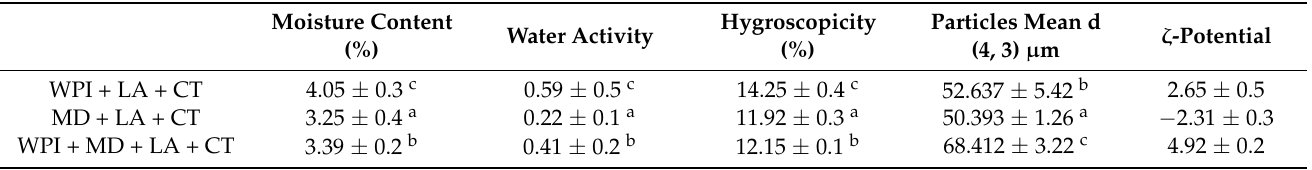
Table 2. Physicochemical characteristics of microparticles WPI + LA + CT, MD + LA + CT, and WPI + MD + LA + CT. Whey protein isolate + L. acidophilus + Charantin; MD + LA + CT: Maltodextrin + L. acidophilus + Charantin; WPI + MD + LA + CT: Whey protein isolate + Maltodextrin+ L. acidophilus +